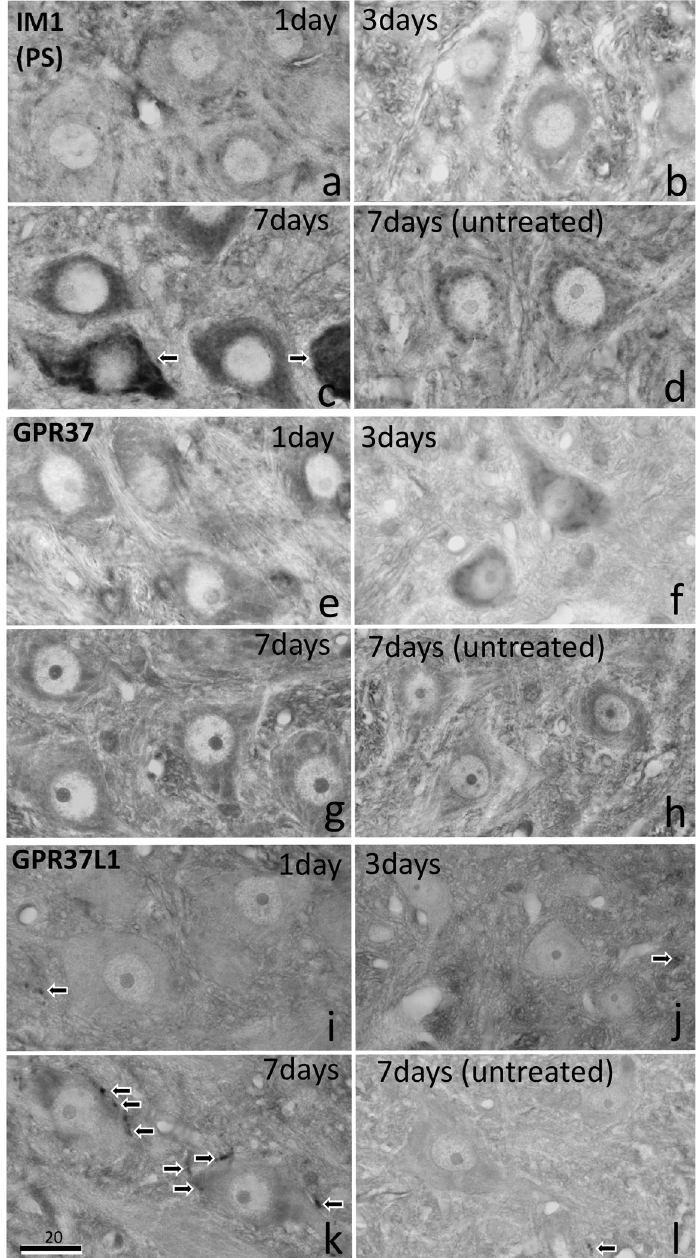
Fig 3. PS, GPR37, and GPR37L1 immunoreactivity (IR) with DAB staining on days 1, 3, and 7 after facial nerve transection. PS-IR decreased slightly on day 1 (a), but increased moderately on day 3, and increased strongly on day 7 (c). Some motoneurons showed very intense PS-IR signal (arrows), whereas others were moderate. GPR37-IR showed a weak increase in the motoneurons on the operated side on days 1, 3, and 7 (e, f, g) compared with the levels on the untreated side (h). GPR37 L1-IR signal was observed in glial cells (arrows) around the motoneurons of the facial nucleus predominately on the operated side on day 7 (k), but not on the untreated side (l) or on days 1 or 3 (i, j). The numbers on the bars indicate the scale in